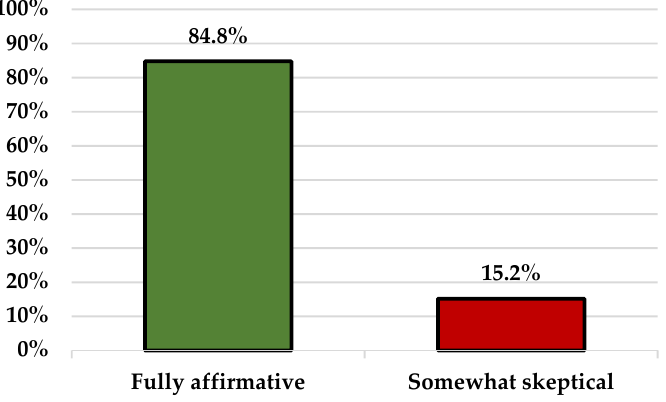
Figure 1. The overall attitudes towards vaccination .